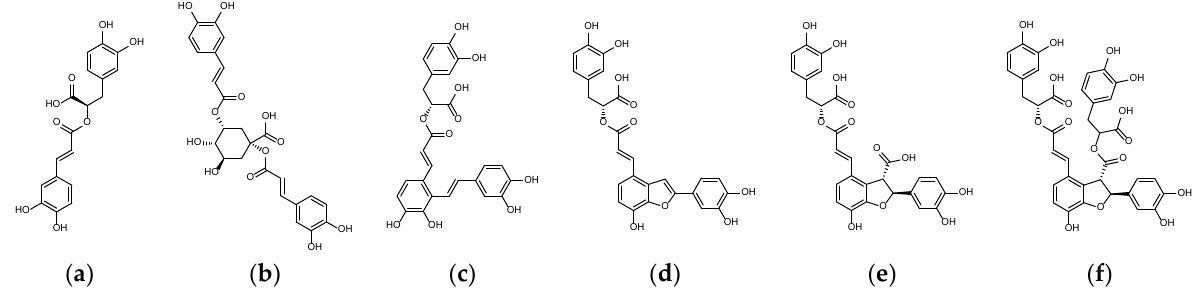
Figure 3. The six phenolic acids in Salvia miltiorrhiza and Cynara scolymus . ( a ) Rosmarinic acid (RosA); ( b ) Cynarin (CY); ( c ) Salvianolic acid A (SalA); ( d ) Salvianolic acid C (SalC); ( e ) Lithospermic acid (LSA); and ( f ) Salvianolic acid B (SalB).